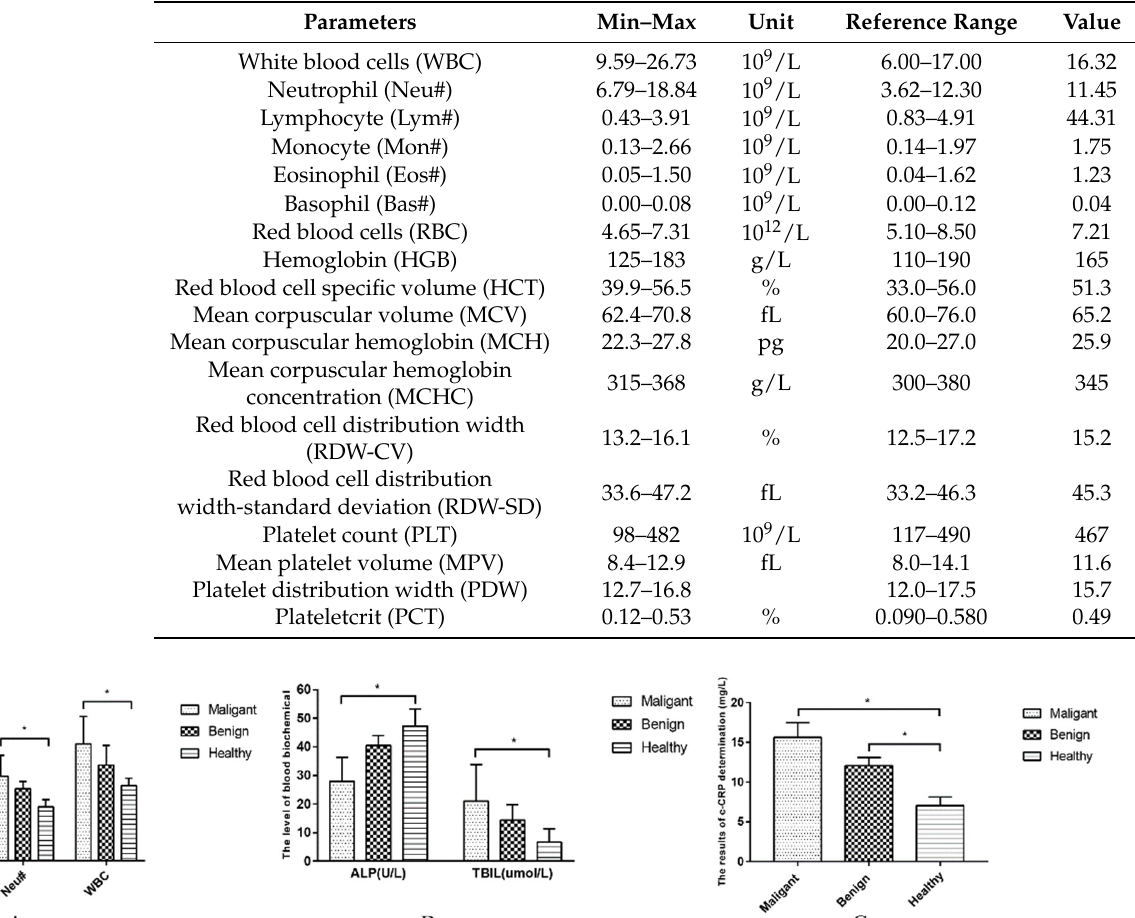
Table 2. Results of routine blood tests.